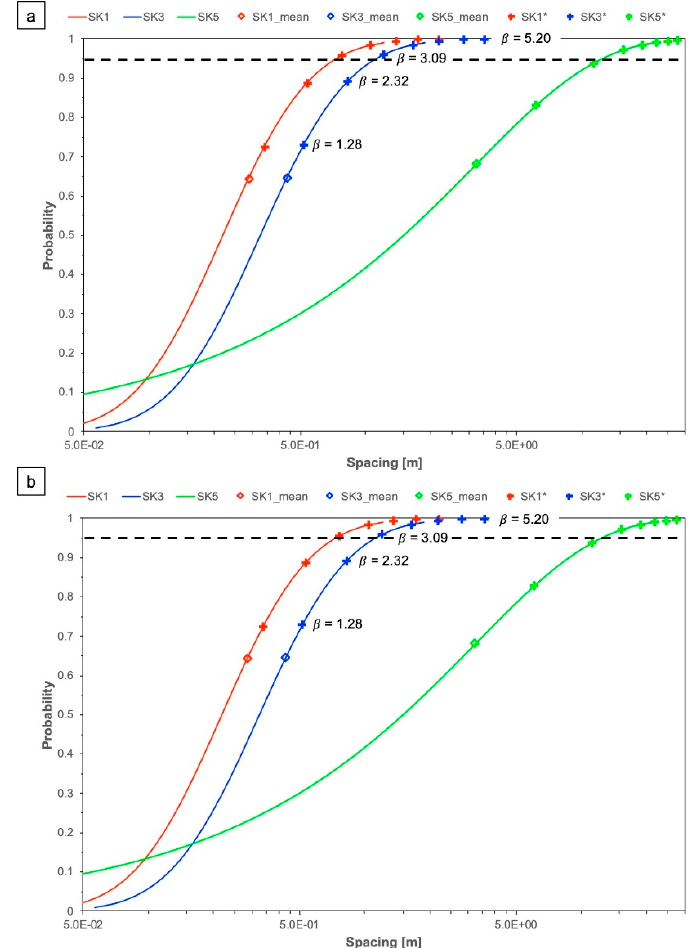
Figure 6. Spacing cumulative probability distribution of each discontinuity set. Diamond markers are the average values; cross markers are the design point values evaluated by using the RBD approach considering H min ( a ) and H max ( b ).